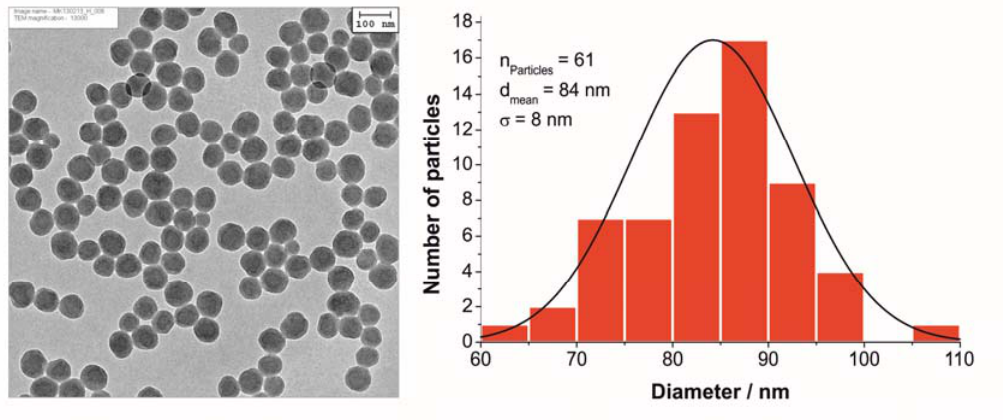
Figure 2. TEM image ( left ) and corresponding size distribution ( right ) of monodisperse nanoparticles consisting of styrene, divinylbenzene and sodium styrene